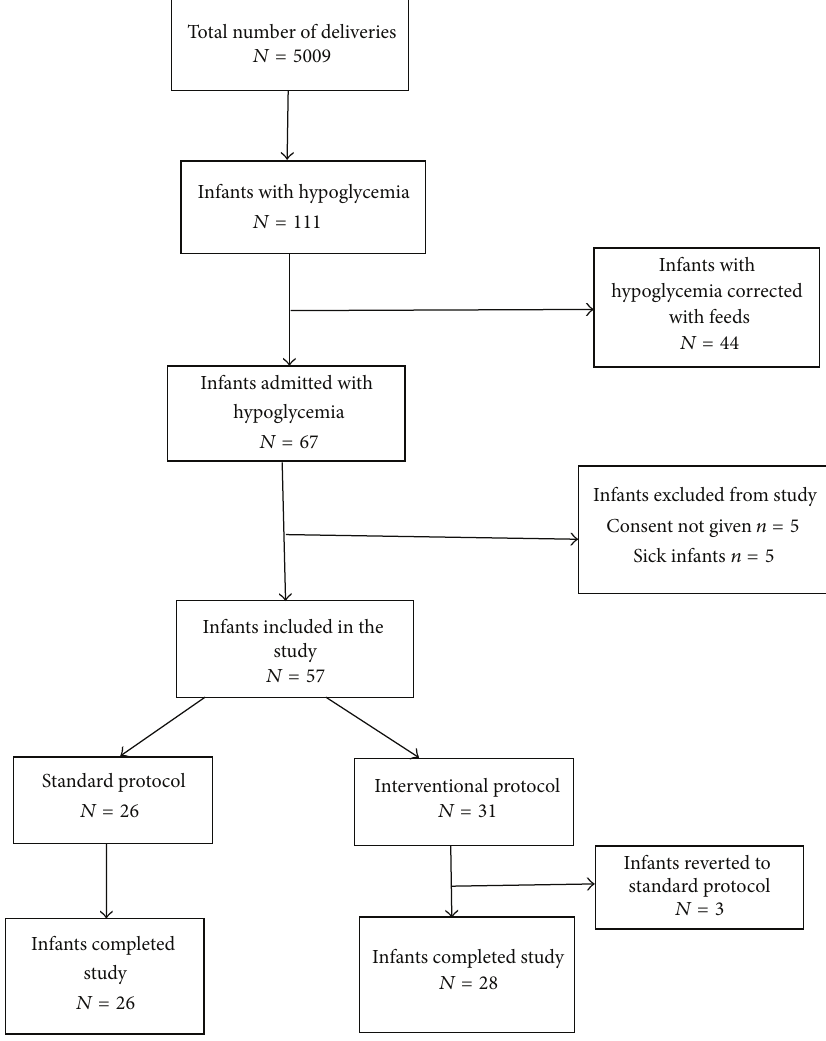
Figure 1: Study flow